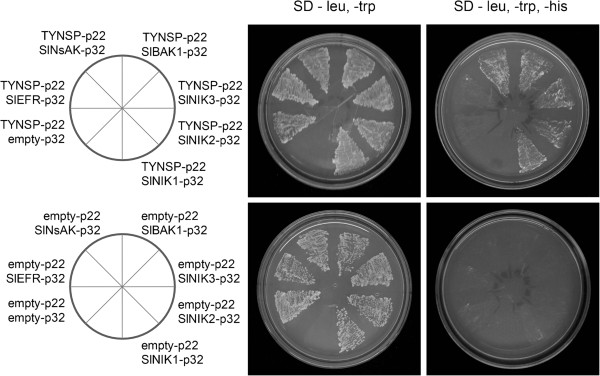
Tomato members of the LRRII and PERK subfamilies interact with NSP of ToYSV. Yeast two-hybrid assay using the kinase domain of LRRII and PERK subfamily members of tomato as bait and the NSP of ToYSV as prey. All co-transformed yeast strains were grown on synthetic defined (SD) medium lacking leucine and tryptophan (SD-leu, -trp), indicating the presence of both plasmids constructs in their cells. Yeast growth on SD medium lacking leucine, tryptophan and histidine (SD -leu, -trp, -his) indicates an interaction between the bait and prey constructs. This was observed in the yeast strains co-expressing NSP and SlNIK1, SlNIK2, SlNIK3, SlBAK1 or SlNsAK. No interaction between NSP and SlEFR was observed. All negative controls using empty vector failed to grow on SD -leu, -trp, -his, indicating the absence of transactivation.